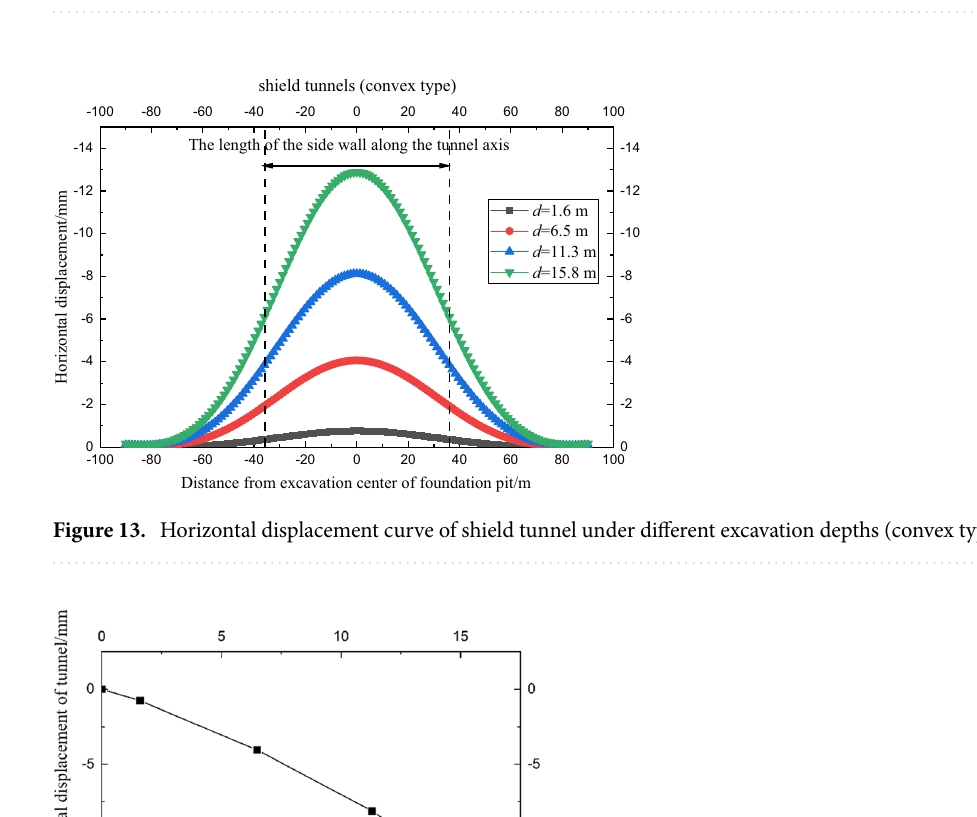
Figure 12. Longitudinal distribution of the amount of dislocation between the rings and the corners between the shield tunnels (convex type).